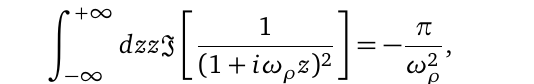
Figure 4: Quantum contribution to the differential conductance in units of G ω = 0 as a function of the Aharonov-Bohm phase ( Φ ). Also in this case every curve is properly 0 further rescaled with respect to the factor ( ω ρ τ σ ) a j e − γ j in order to keep track of the interaction induced renormalization of the tunneling amplitudes for the non interacting case ( j = 0, full black curve), the one trapped channel case ( j = 1, dashed blue curve) and the two trapped channels case ( j = 2, dotted-dashed red curve). Parameters are: τ σ = 1, ω ρ τ σ = 1000, | Λ | = | Λ | = | Λ | and ħ h = 1 2